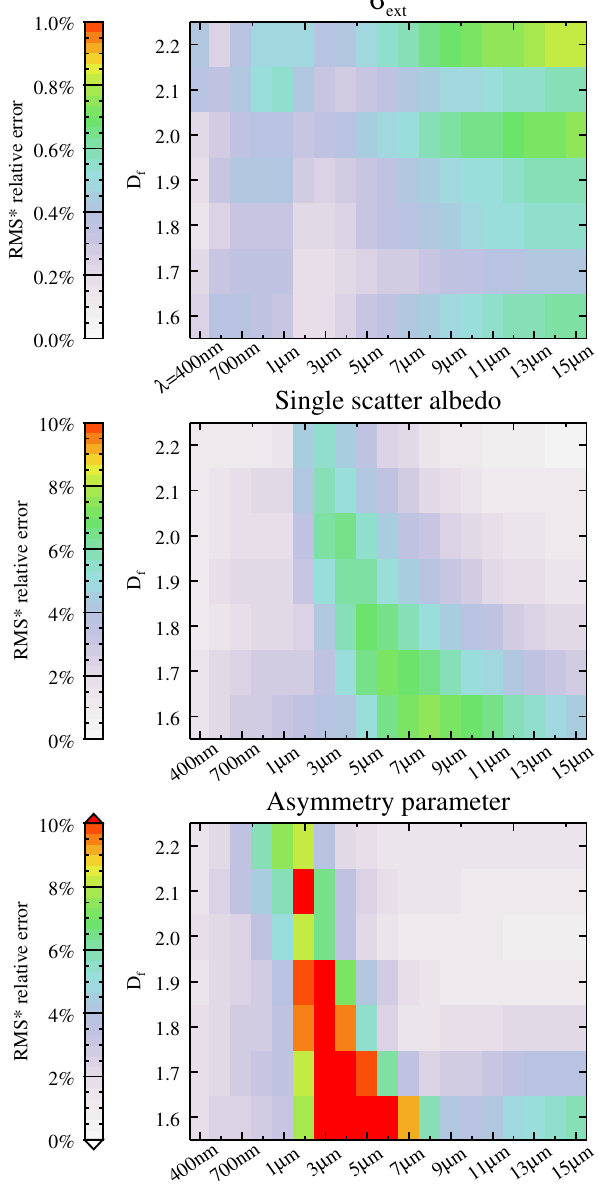
Figure 10. The relative RMSEs between the calculated and param- eterised values of σ ext , SSA, and g . Calculations of rms exclude the lowest two values of n s as discussed in the text.